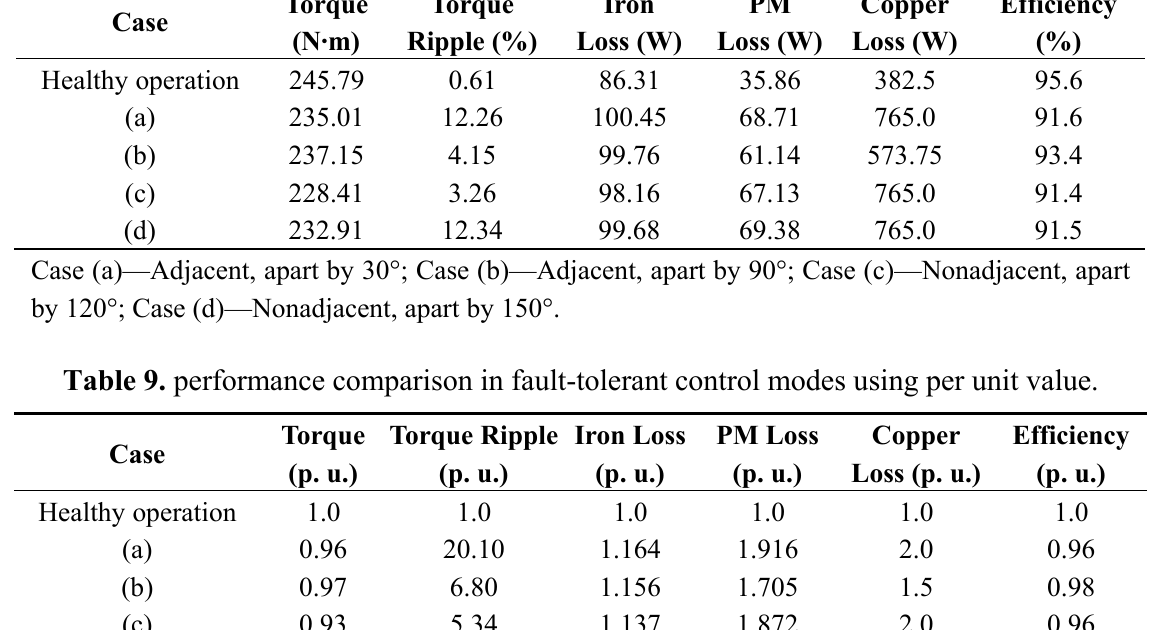
Table 8. Motor performance in fault-tolerant control modes based on FEA. Case